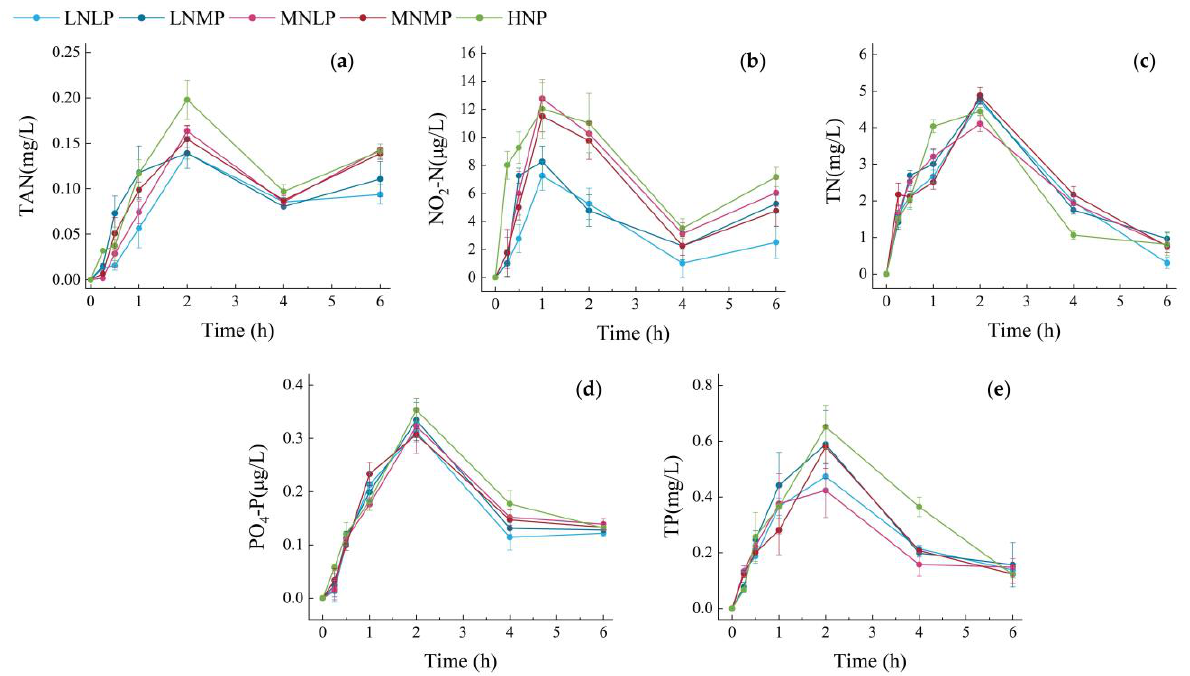
Figure 2. Time variations in water quality parameters within 6 h after feeding. ( a ) Total ammonia nitrogen, ( b ) nitrite nitrogen, ( c ) total nitrogen, ( d ) labile phosphate, and ( e ) total phosphorus.